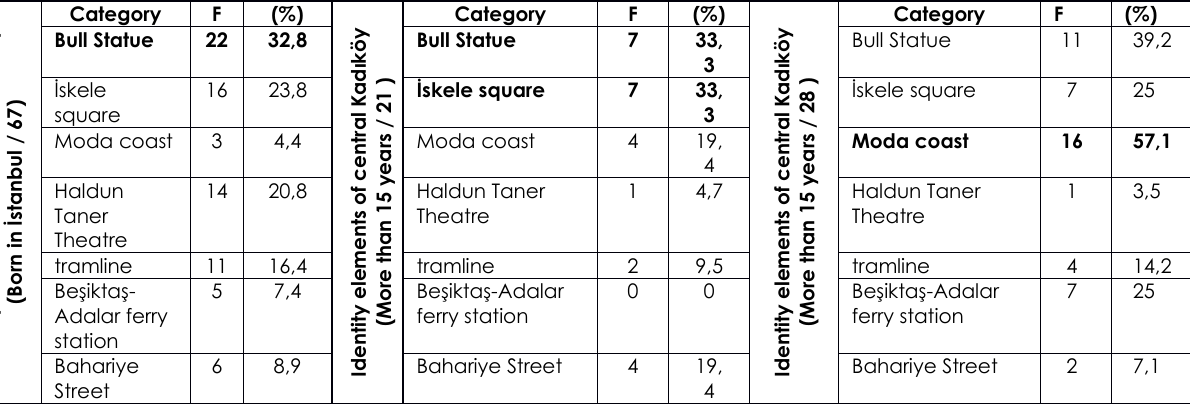
Table 5. The Analysis of Identity Elements via Variable of Duration of